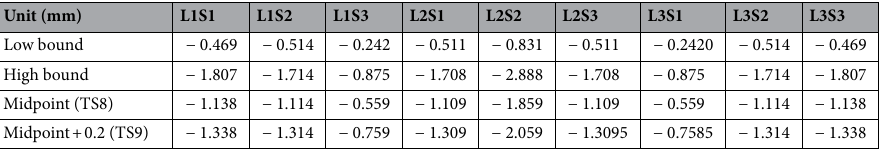
Table 6. The target deflection sets for double void 20 voxel